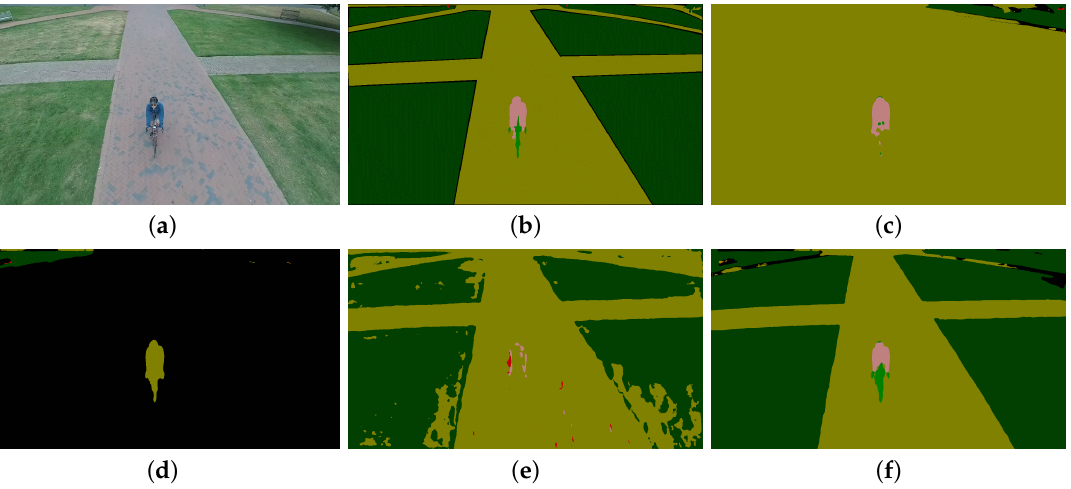
Figure 10. Visualization results of different methods on the adversarial example test set in the AeroScapes dataset. ( a ) Original Images. ( b ) Ground Truth. ( c ) MANet [16]. ( d ) HPSNet [17]. ( e ) TCHNet [70]. ( f )